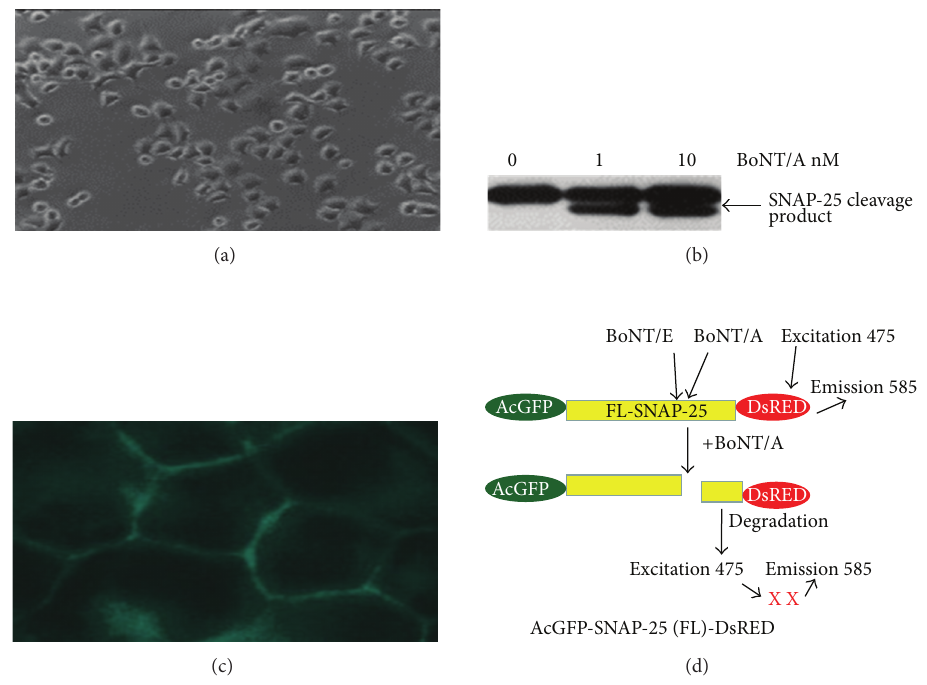
Figure 1: (a) Morphology of PC12 cells acquired under bright field microscopy ( × 40) cultured according to standard methods. (b) Sensitivity of PC-12 cell lines to BoNT/A as shown by SNAP-25 cleavage efficiency. Western blot image of PC-12 cells lysate after treatment with BoNT/A. The cleavage product marked by an arrow. (c) Immunofluorescence staining of methanol-fixed PC-12 cells showing SNAP-25 membrane localization. Image was acquired using a Nikon Eclipse Ti-E confocal microscope (Nikon Inc., USA). (d) Schematic representation of the BoNT sensor constructs. A fusion protein construct with full-length SNAP-25 as a linker between AcGFP1 and DsRED-monomer was created resulting in the AcGFP-SNAP-25-DsRed construct. Arrows indicate the site of cleavage by BoNT/A, -C, -E.